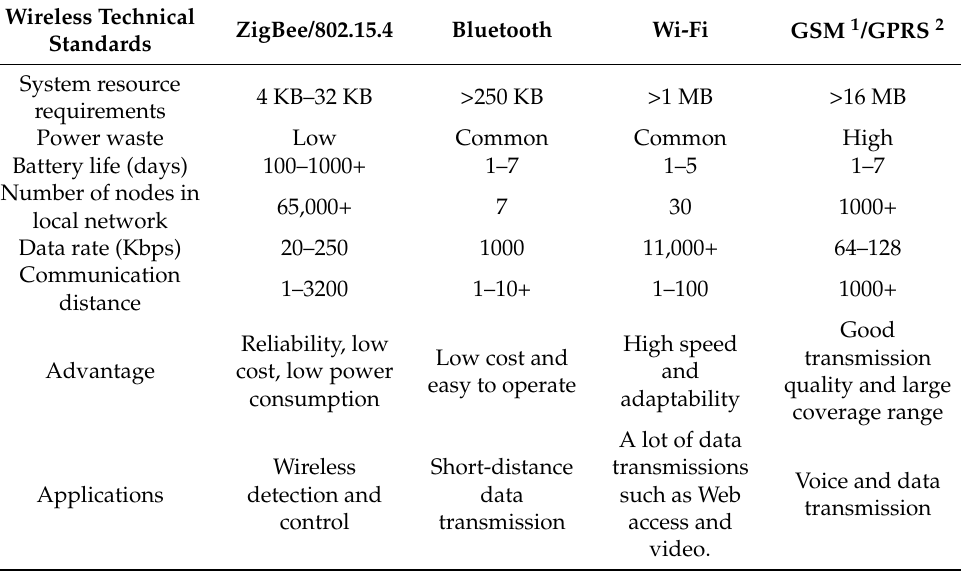
Table 1. Comparison of wireless communication technologies (modified from Duan and Chen